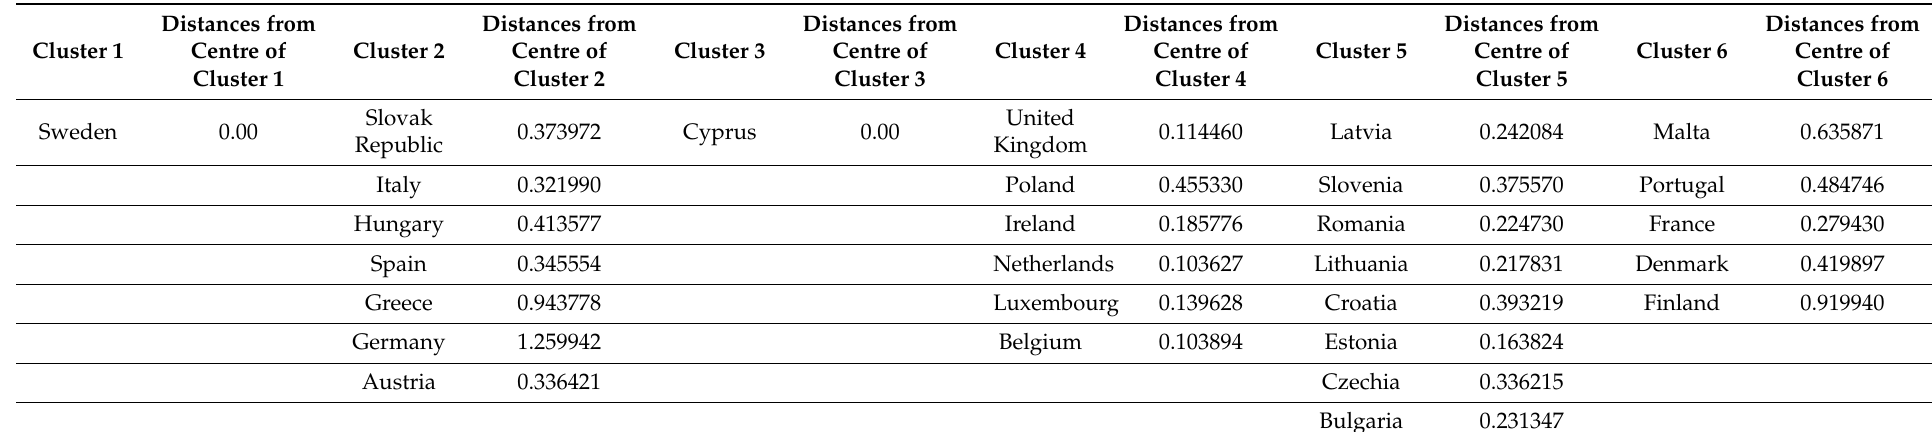
Table 1. Elements of clusters with distances from